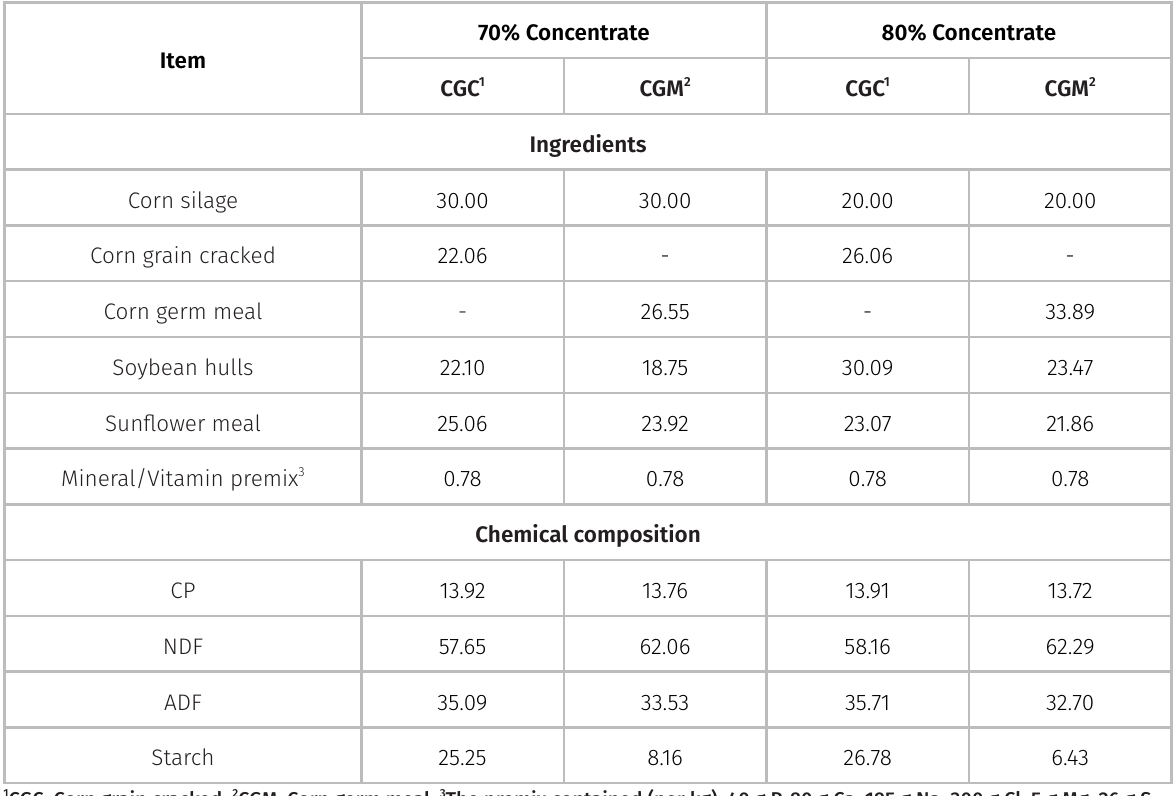
Table I. Ingredient and chemical composition of the diets experimental (% DM).